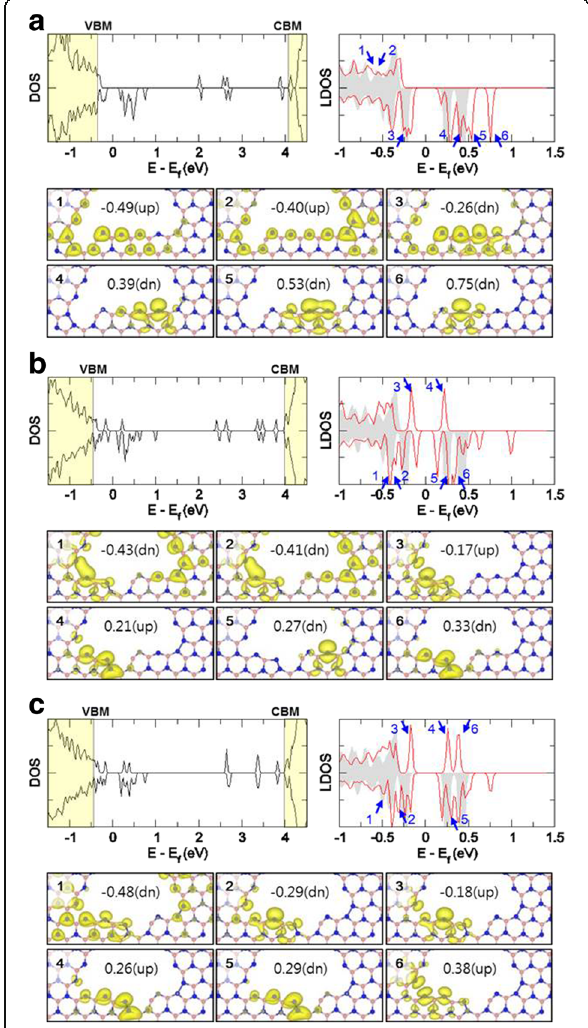
Fig. 4 Total DOS, LDOS of edge N atoms and the spin density plots near the Fermi level for the optimized structures of V 21B+15N vacancy structure with BN-pair missing: a corner-1 missing, b face-2 missing, and c face-3 missing structures. The light yellow shaded regions in total DOS represent the regions of valence bands and conduction bands of the pristine h -BN sheet, respectively. The grey shaded and red solid-line features are LDOS of N atoms before and after BN-pair missing at the edge of triangular vacancy